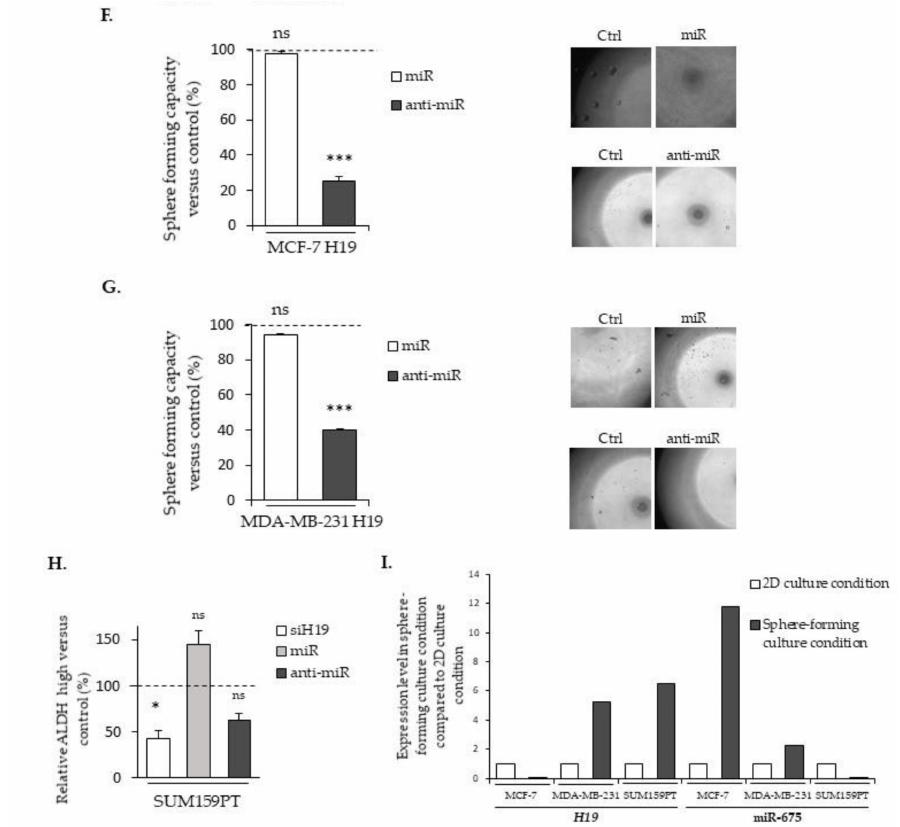
Figure 7. H19 and miR-675 enhance the sphere formation of breast cancer cells. ( A ) Sphere-forming capacities of the control (mock) or H19 -stably overexpressing cells (H19). ( B ) The relative sphere-forming capacities of SUM159PT-pH19-mCherry neg versus SUM159PT-pH19-mCherry high . ( C ) The sphere-forming capacities of the control (siCtrl) and H19 -knockdown cells (siH19). ( D ) The sphere-forming capacities of the MDA-MB-231 control (mock) or miR-675-stably overexpressing cells (miR-675). ( E ) The sphere-forming capacities of miR-675-transfected cells (miR) or miR-675-specific inhibitor transfected cells (anti-miR). Results are presented as a percentage of the control. ( F ) The sphere-forming capacities of MCF-7 H19 -stably overexpressing cells transfected with miR-675 (miR) or the miR-675-specific inhibitor (anti-miR). Results are presented as a percentage of the control. Representative pictures for each condition are shown. ( G ) The sphere-forming capacities of MDA-MB-231 H19 -stably overexpressing cells transfected with miR-675 (miR) or the miR-675-specific inhibitor (anti-miR). Results are presented as a percentage of the control. Representative pictures of each condition are shown. ( H ) ALDEFLUOR-positive subpopulations defined by the ALDEFLUOR assay in H19 -knockdown cells (siH19), miR-675-transfected cells (miR) or miR-675-knockdown cells (anti-miR). Results are presented as a percentage of the ALDEFLUOR-positive subpopulation in the native cells. ( I ) The expression levels of H19 and miR-675 in the cell lines cultured in sphere-forming conditions versus the same cell lines cultured in 2D conditions. * p < 0.05; ** p < 0.01; *** p < 0.001; ns: not